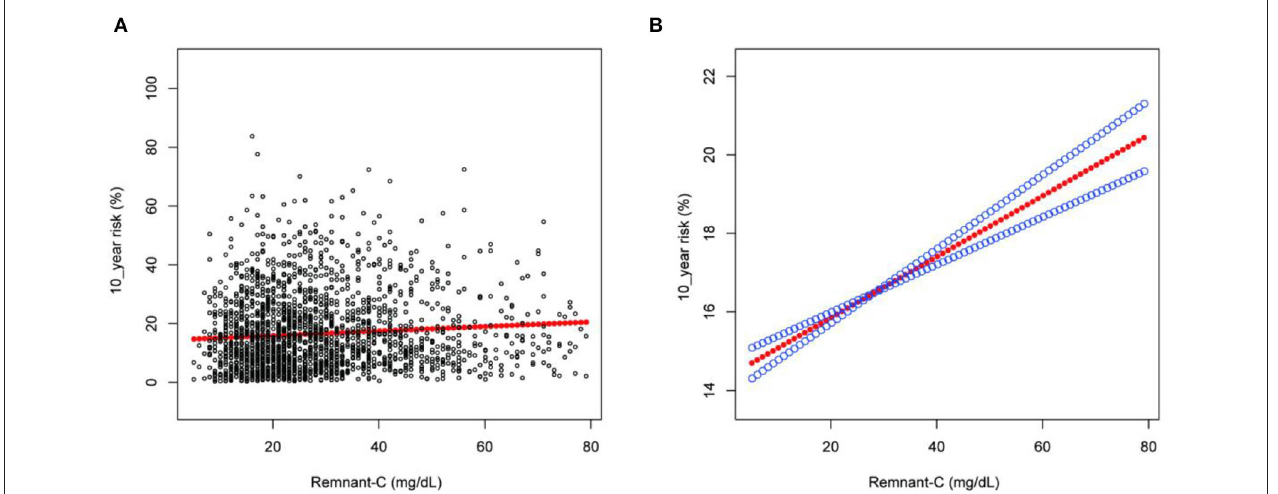
FIGURE 1 | The association between Remnant-C and the 10-year risk of a first hard ASCVD event. (A) Each black point represents a sample. (B) Solid red line represents the smooth curve fit between variables. Blue lines represent the 95% of confidence interval from the fit. Gender, age, race, body mass index, systolic blood pressure, diastolic blood pressure, hypertension treatment, smoking, diabetes, and low-density lipoprotein cholesterol were adjusted. Remnant-C, remnant cholesterol.